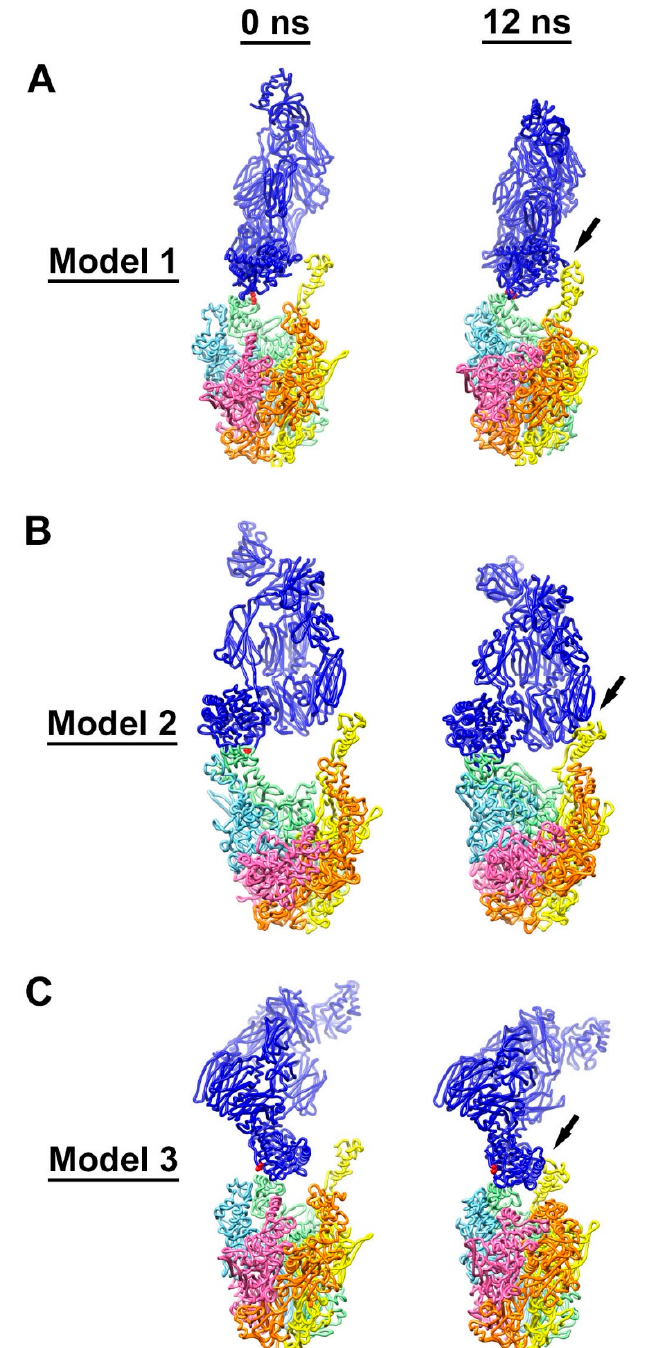
Figure 6. Interaction of C4b with multiple RGD loops of HAdV-C5 penton base. ( A ) Initial (0 ns) and final (12 ns) coordinates from the model 1 molecular dynamics simulation with a covalent bond between Thr343 of penton base chain C (green) and C4b (blue). The covalently linked residues, Thr343 of penton base and Cys1010 of C4b, are in red. ( B ) Coordinates from the model 2 simulation with a covalent bond between Arg347 of penton base chain C (green) and C4b. The covalently linked residues, Arg347 of penton base and Cys1010 of C4b, are in red. ( C ) Coordinates from the model 3 simulation with no covalent bond between penton base and C4b. Cys1010 of C4b is in red. Penton base subunits are colored as in Figure 5. Penton base is shown in a different orientation for each simulation. The final coordinates from all three simulations show additional favorable interactions indicated with arrows between C4b and penton base chain D